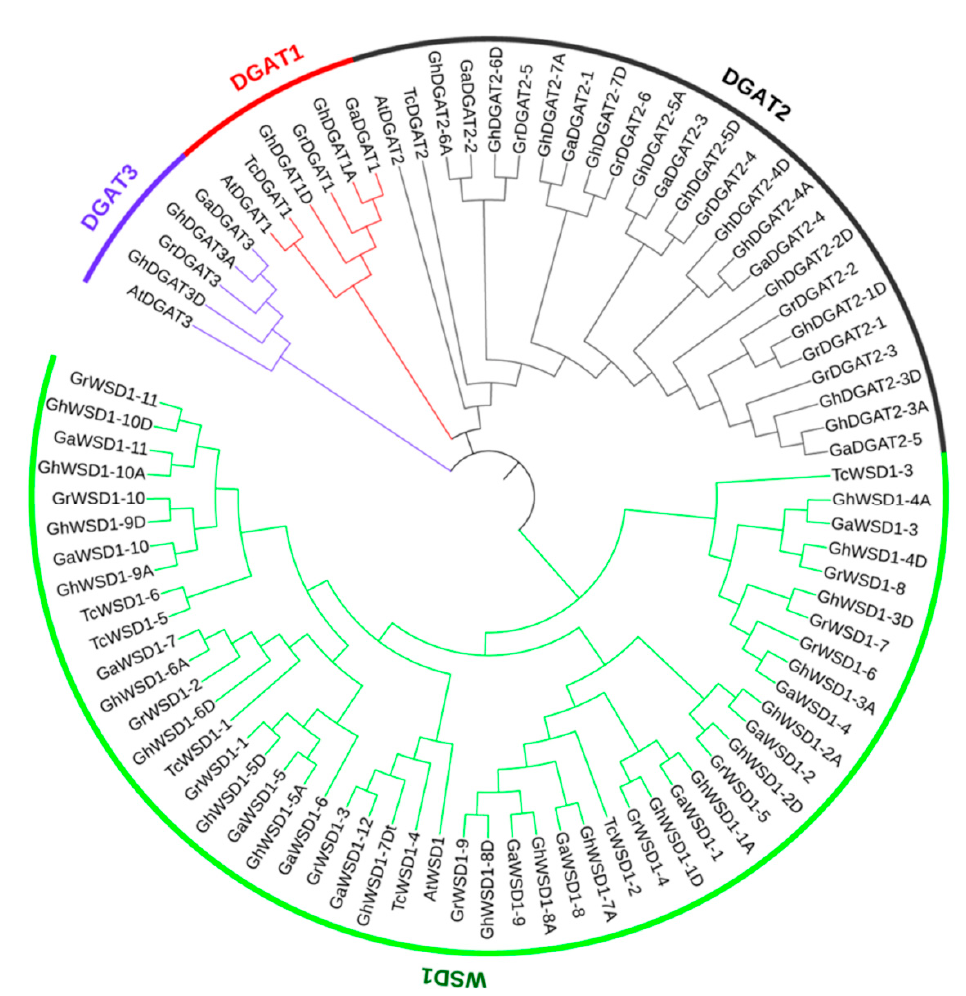
Figure 1. Phylogenetic tree of the DGAT and WSD1 protein family. The phylogenetic tree was constructed using MEGA-X and displayed using iTOL software. At: Arabidopsis thaliana ; Tc: Theobroma cacao ; Gh: G. hirsutum ; Ga: G. arboretum ; Gr: G. raimondii .